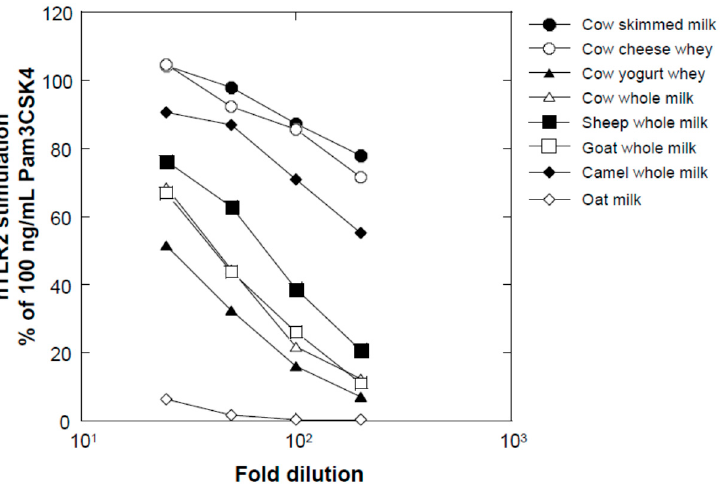
Figure 5. Comparison of different milk components used in the culture medium for TL24. Cow skimmed milk (closed circles), cow cheese whey (open circles), cow yogurt whey (closed triangles), cow whole milk (open triangles), sheep whole milk (closed squares), goat whole milk (open squares), camel whole milk (closed rhombuses), and oat milk (open rhombuses) were used as milk components mixed (individually) with a hot water extract of asparagus. The culture supernatants were sampled after TL24 fermentation at 37 ° C for 24 h and heat-treated at 110 ° C for 20 min, followed by the examination of their TLR2-stimulating activities. (n = 1).